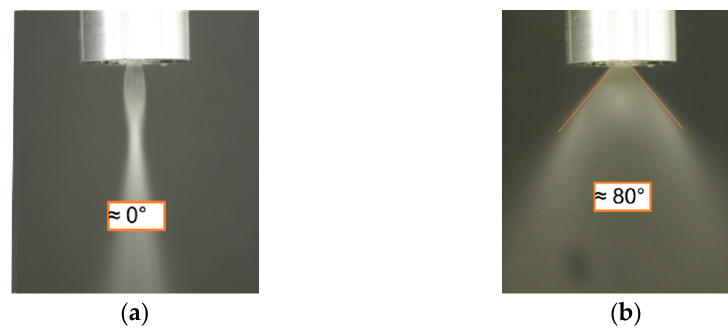
Figure 5. Spray cone angle β for liquid fuel operation on primary 1 and 2, without ( a ) and with ( b ) co-flowing of shielding air at very low pilot fuel flow rate in quiescent air.